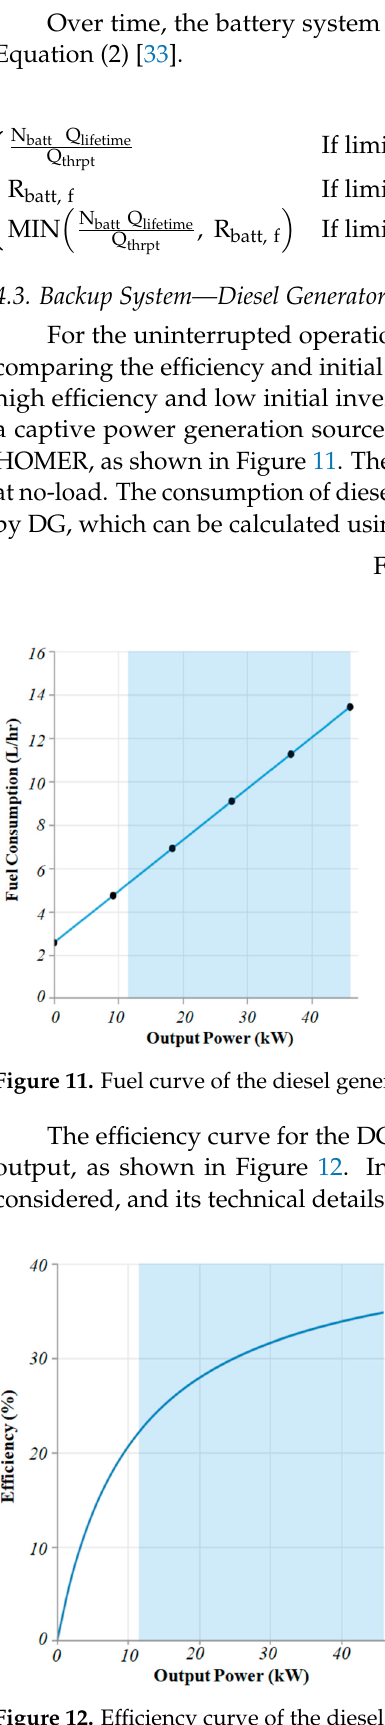
Table 3. Technical details of the battery.